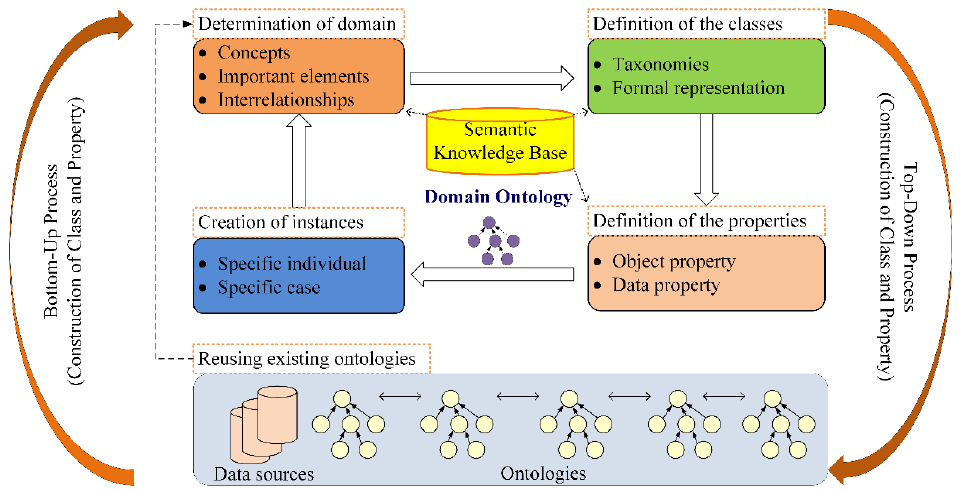
Figure 3. Basic modeling procedure for ontology